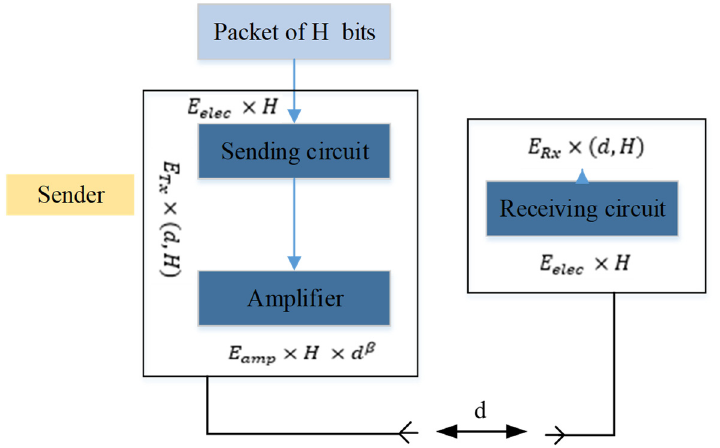
Figure 2. Model of energy consumption.